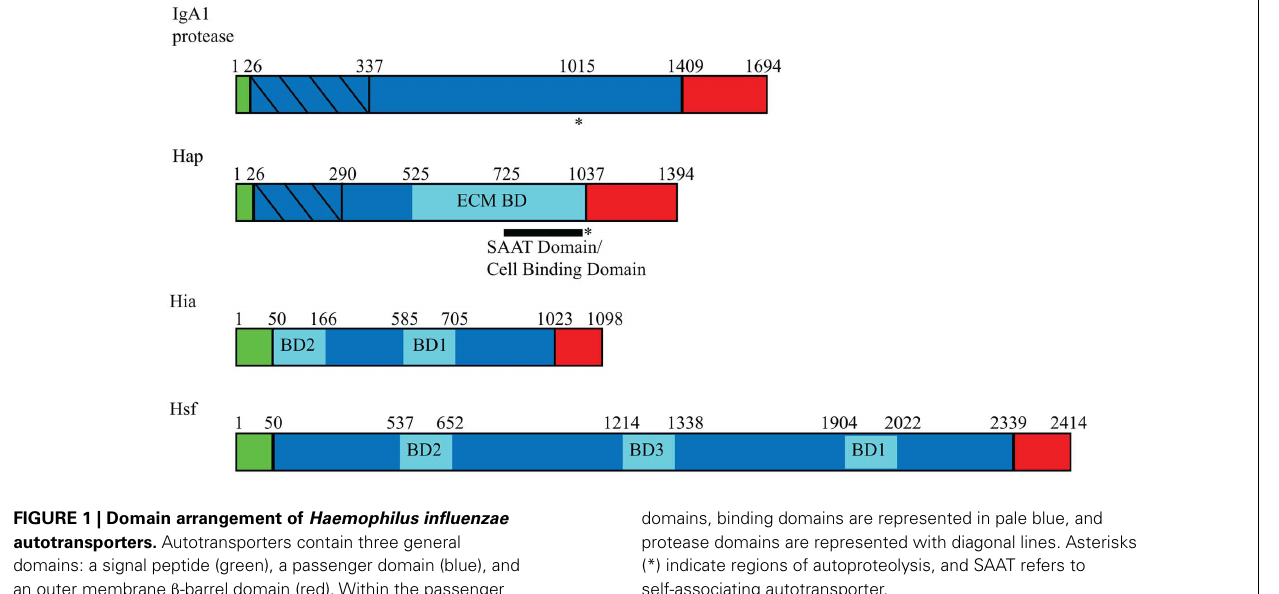
domains, binding domains are represented in pale blue, and protease domains are represented with diagonal lines. Asterisks (*) indicate regions of autoproteolysis, and SAAT refers to self-associating autotransporter.